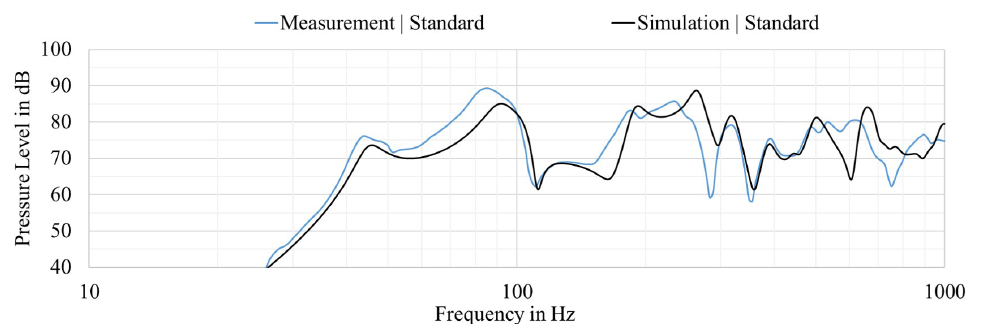
Figure 5. Validation of the measured and simulated pressure response of the panel with the exciter (standard construction) with a closed backside at a 1 m distance and with 2.83 Vrms